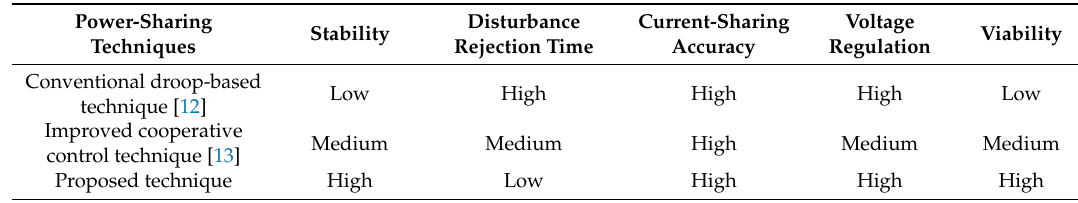
Table 1. Comparison of different power-sharing techniques.